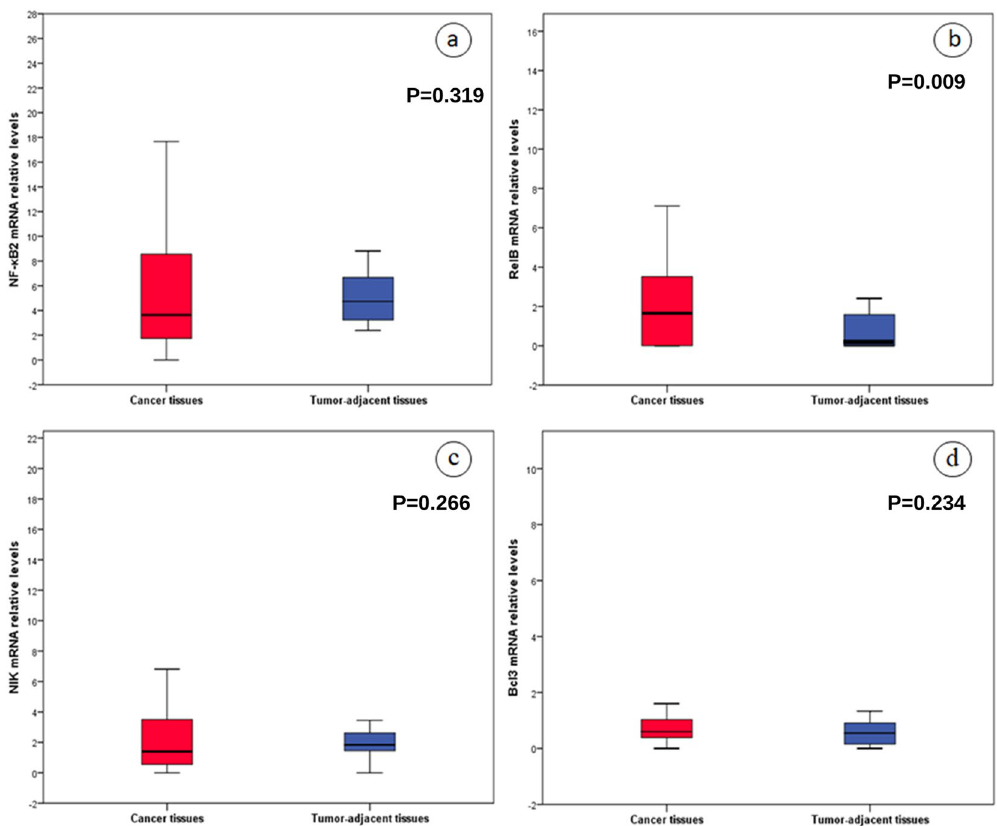
Figure 3. Relative expression in mRNA levels of ( a ) NF- κ B2 , ( b ) RelB , ( c ) NIK and ( d ) Bcl3 genes in tumor and tumor-adjacent